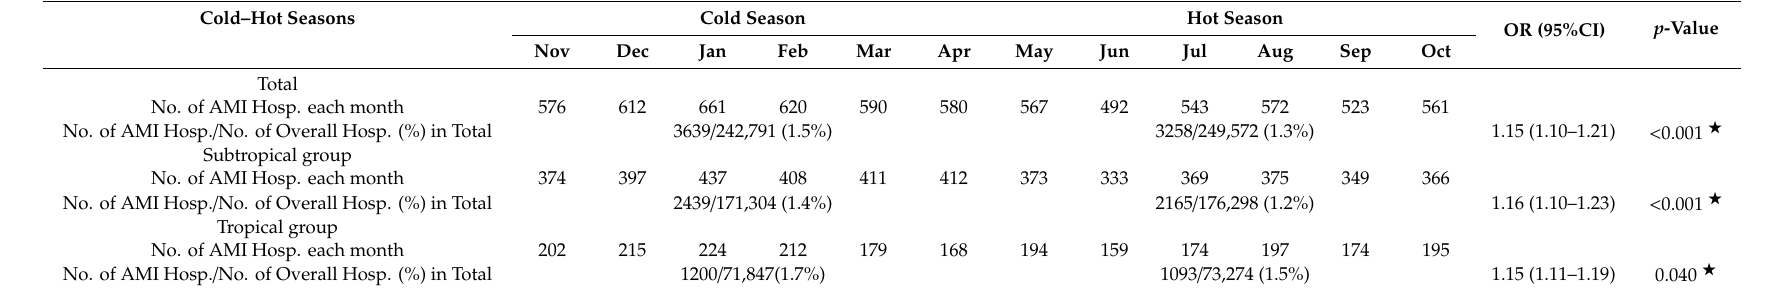
Table 3. Comparison of acute myocardial infarctions (AMI) hospitalizations between the cold and hot seasons. Cold–Hot